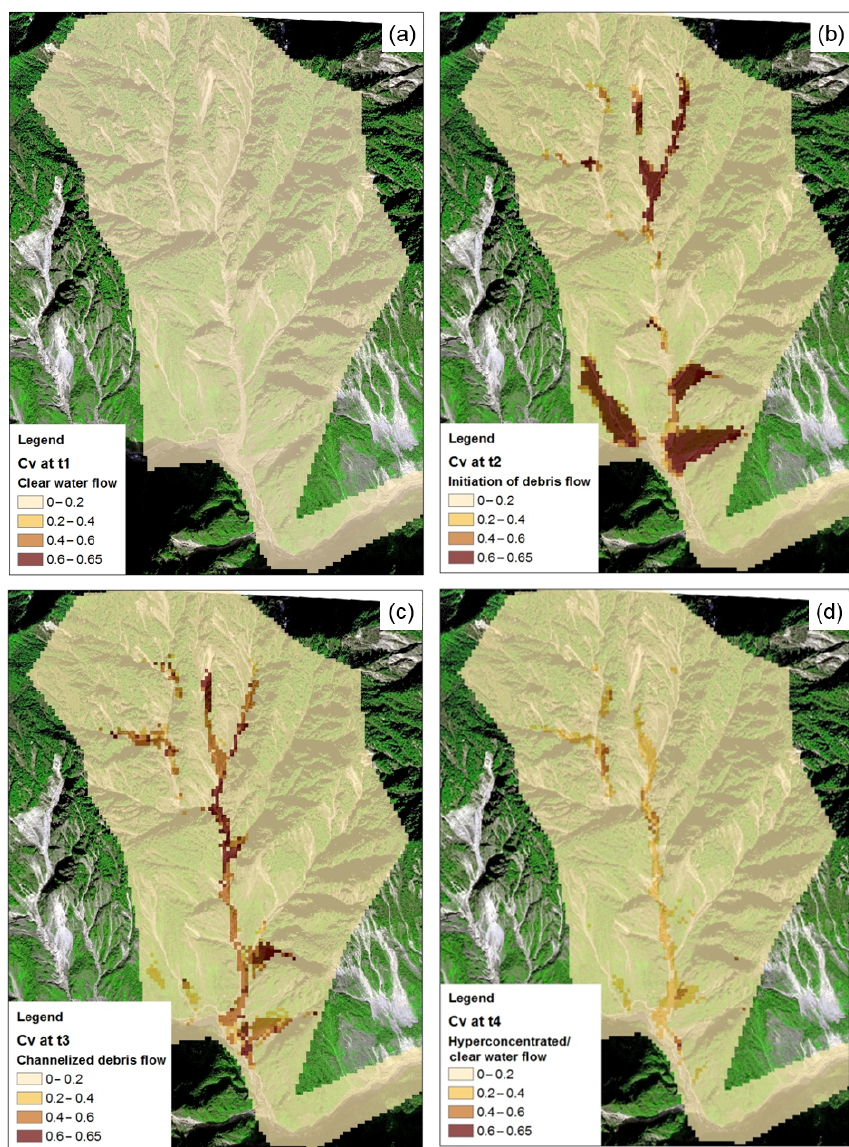
Figure 13. Distributions of C v at different times during the storm event: (a) clear water flow; (b) initiation of debris flows; (c) channelized debris flows; and (d) post hyperconcentrated/clear water